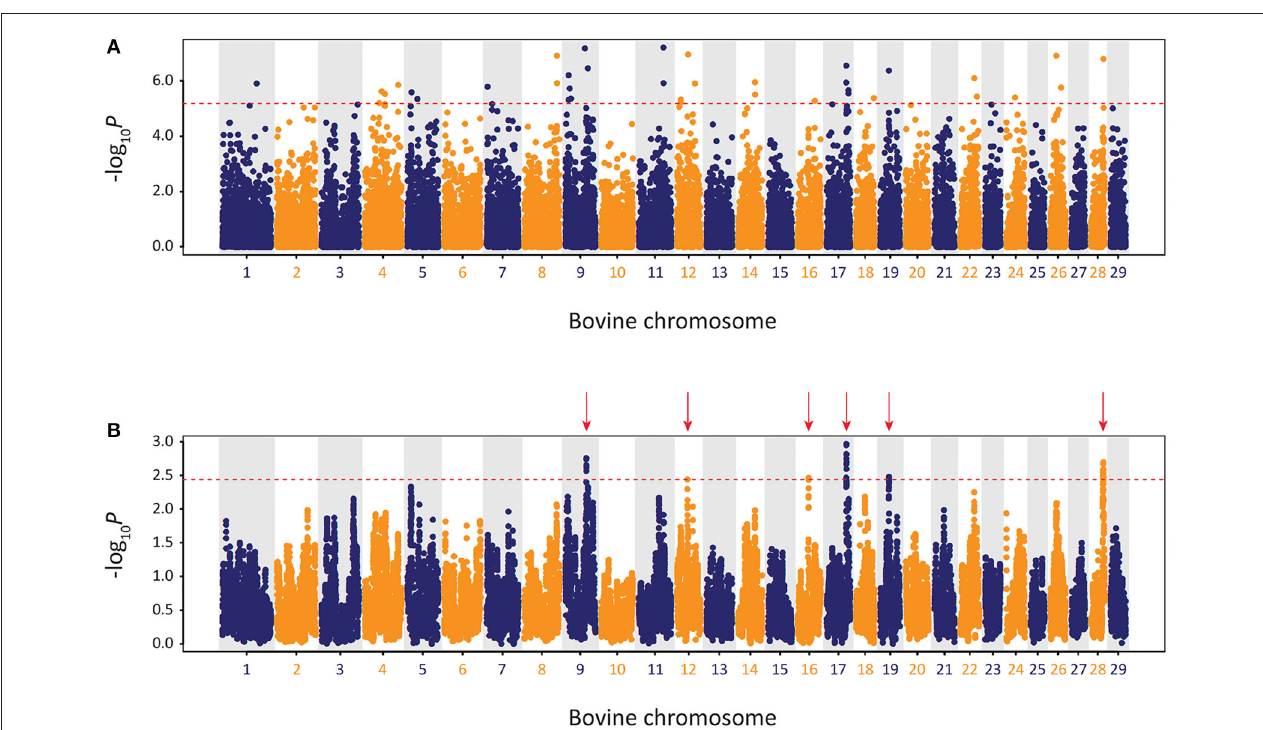
FIGURE 10 | Manhattan plots of composite selection signal (CSS) results for Kerry cattle ( n = 98) contrasted with EU cattle ( n = 102). (A) Unsmoothed results. (B) Smoothed results obtained by averaging CSS of SNPs within each 1Mb window. Red dotted line on each plot denotes the genome-wide 0.1% threshold for the empirical CSS scores. Red vertical arrows indicate selection peaks detected on BTA09, BTA12, BTA16, BTA17, BTA19, and